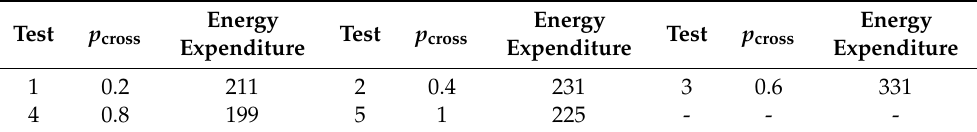
Table 11. Test input parameters of the genetic algorithm [kWh].